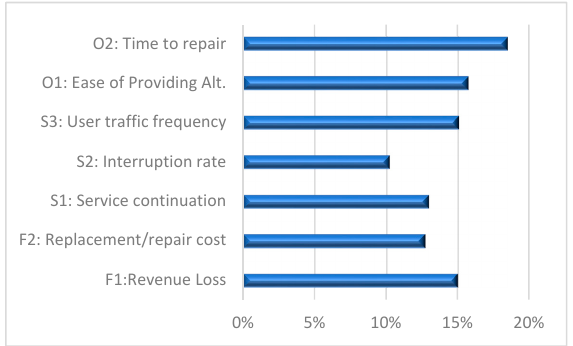
Figure 3. Failure impacts attributes Global Weights.